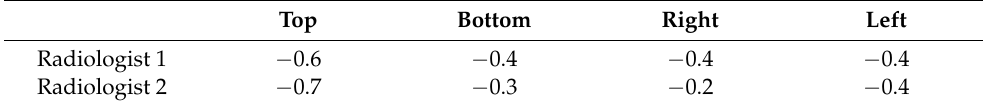
Table 1. Spearman correlation coefficients of top, bottom, right and left unused radiograph space metrics to ranked categories assigned by radiologists.